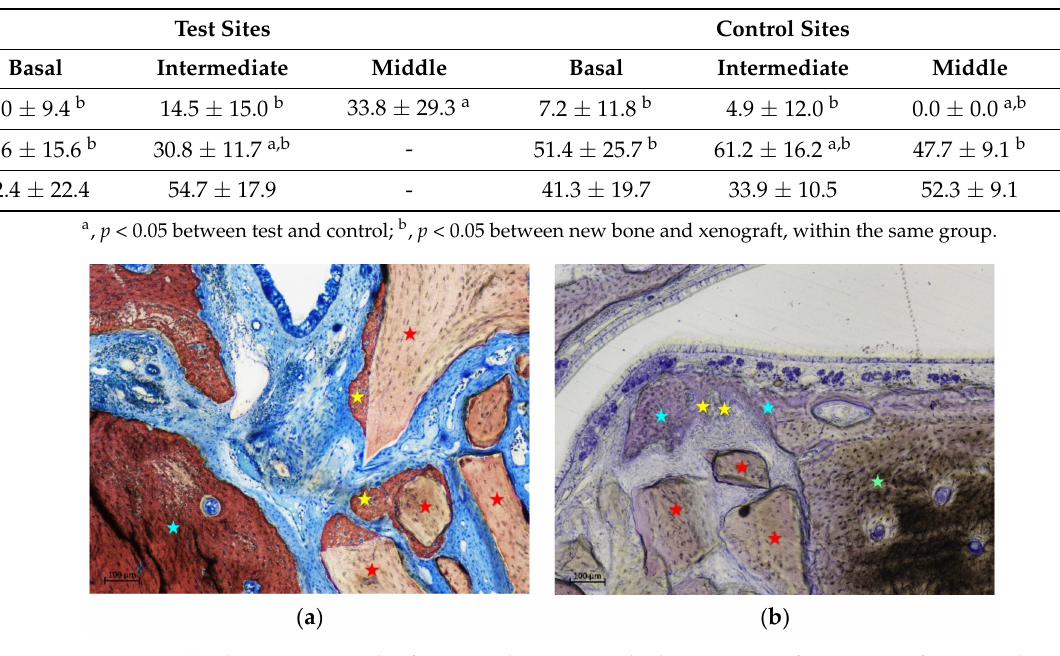
Figure 5. ( a ) photomicrograph of a ground section at the base region of a test site after 4 weeks of healing. The new bone was mainly in connection with the sinus bone walls. ( b ) photomicrograph of a ground section at the base region of a test site after 4 weeks of healing. Note new bone (yellow stars) formed from remnants of old bone (light blue stars) fractured together the bone window (light green star). Some xenograft granules are indicated in red. a, Stevenel’s blue and alizarin red stain; b, Toluidine blue stain.